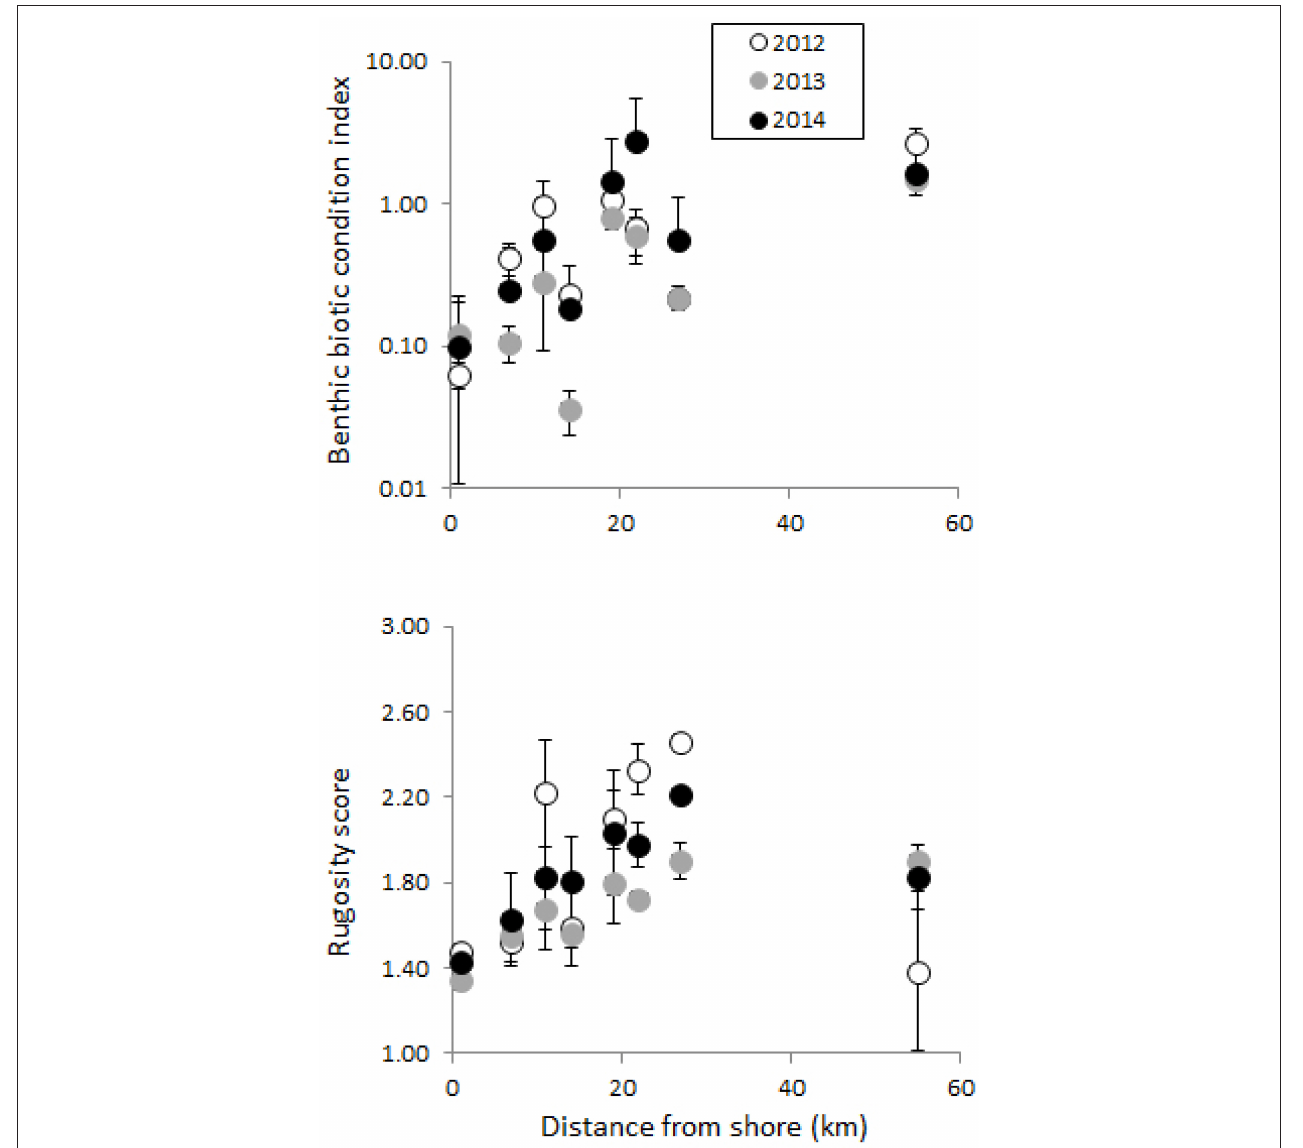
FIGURE 8 | Benthic biotic condition index and reef rugosity score for each year at each site with distance from shore (km). Benthic biotic index is calculated as a ratio between live coral + CCA cover and all other biotic groups (turf algae + macroalgae + sponge + cyanobacteria + other invertebrates).